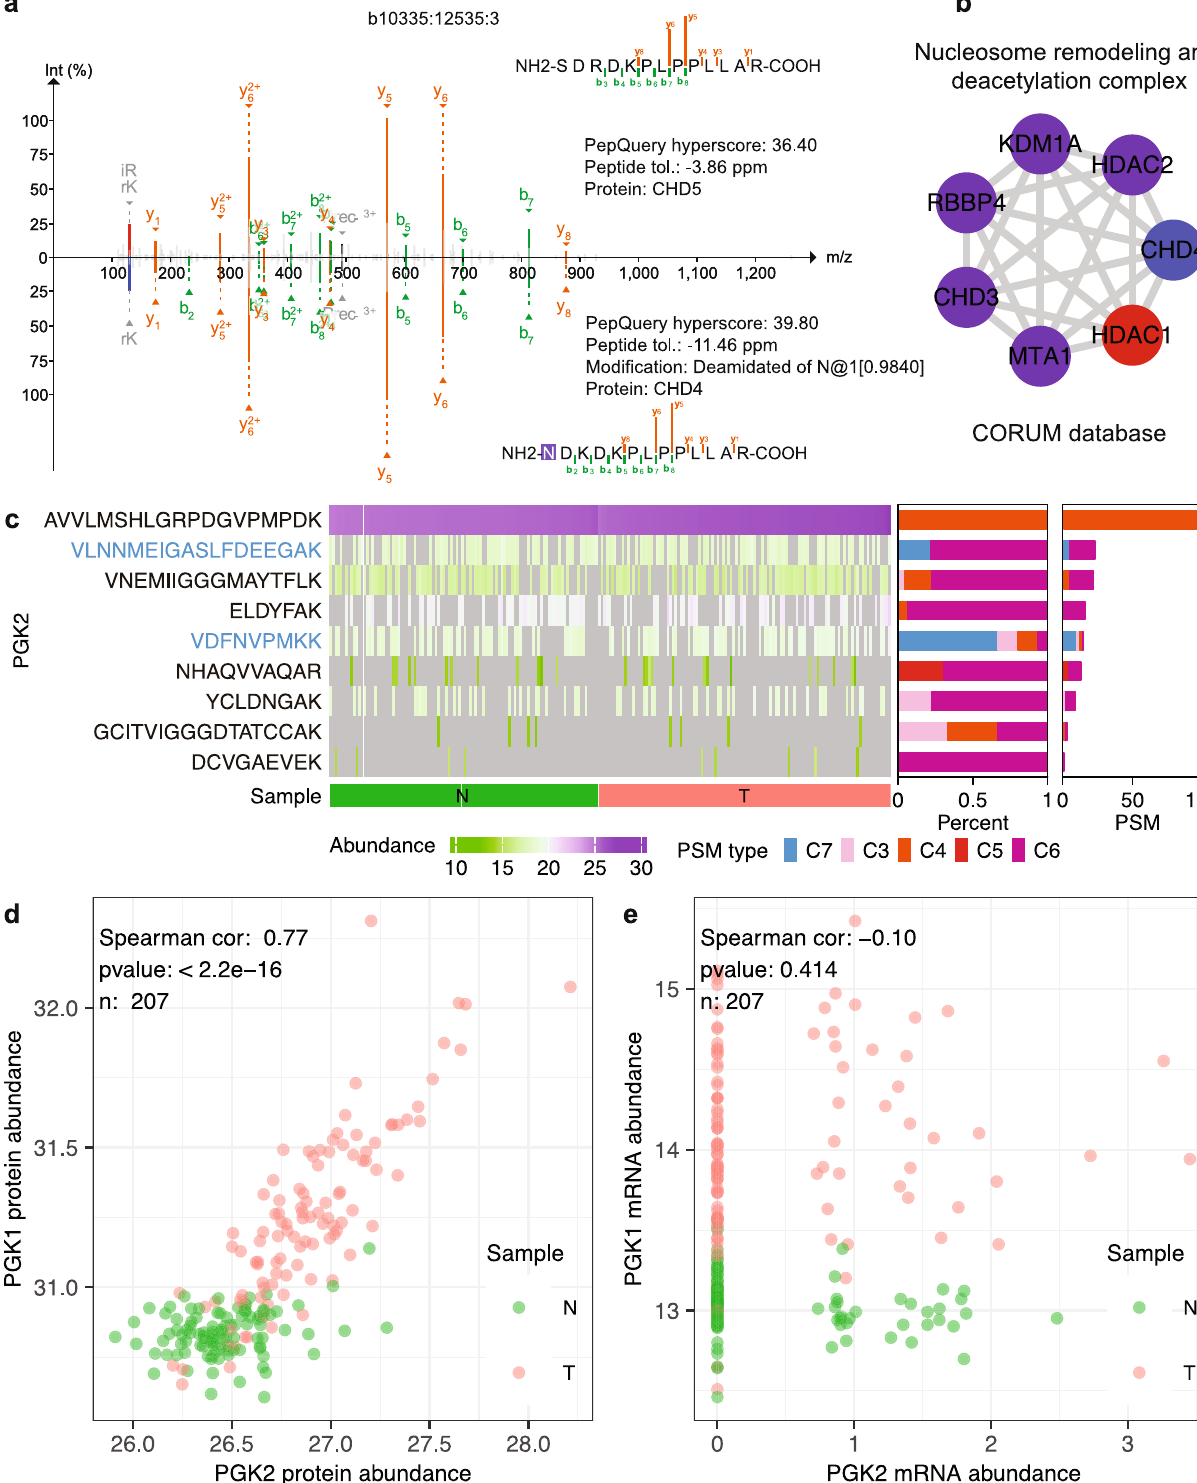
more PSMs passing PepQuery2 validation. d Protein abundance correlation betweenPGK1and PGK2. e mRNAabundancecorrelationbetweenPGK1and PGK2. For d and e, only samples with non-missing and non-zero values in both samples wereconsideredwhencalculatingthespearmancorrelation.Sourcedataof 4c,4d, and 4e are provided as a Source Data fi